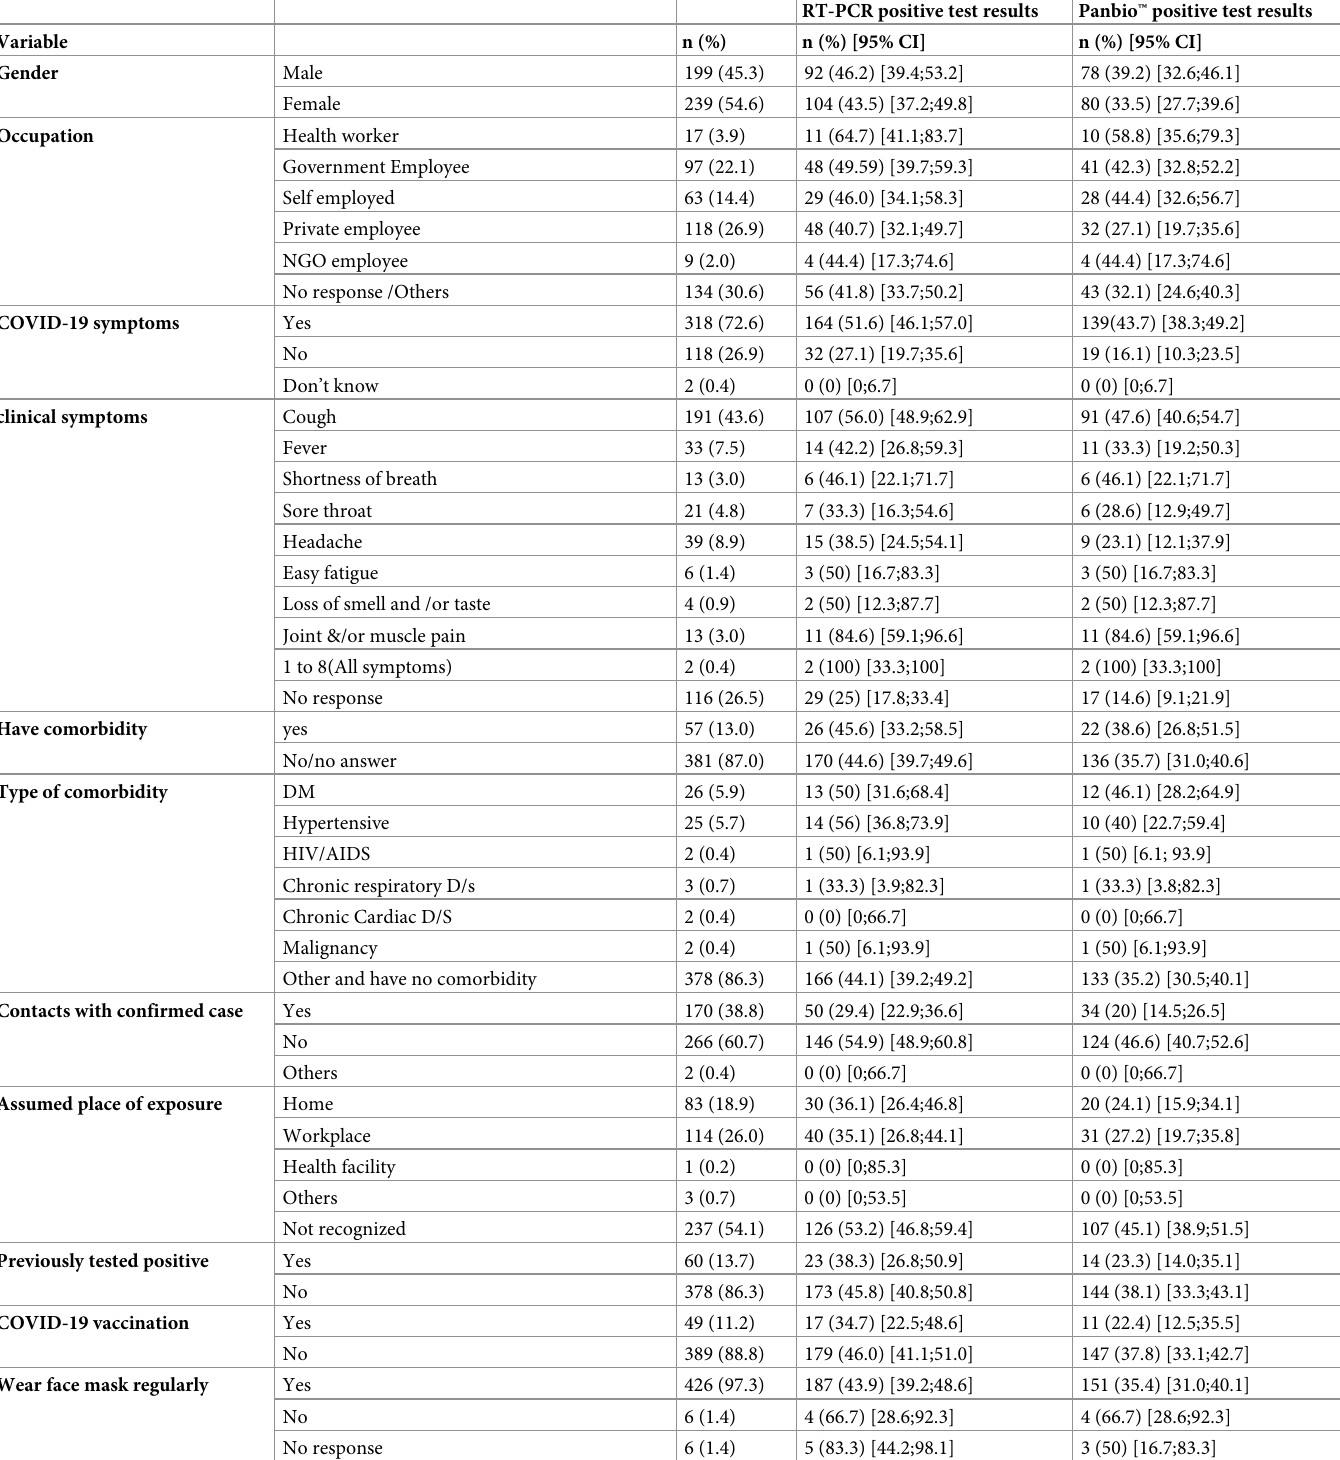
Table 1. Demographic characteristics, including clinical characteristics related to a potential COVID-19 infection, of study participants and cross-classified results of RT-PCR and Panbio ™ , Addis Ababa, Ethiopia, 2021 (n =